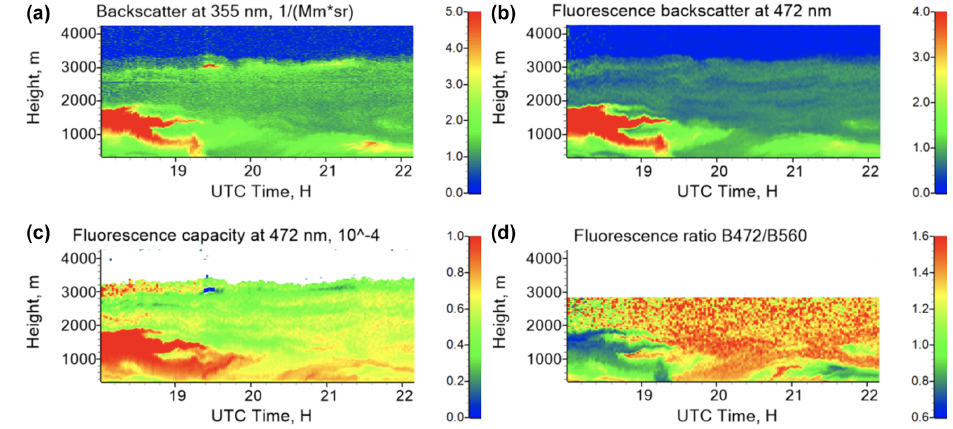
Figure 7. Observations on 17 August 2022. (a, c) Aerosol-backscattering coefficient β 355 and fluorescence capacity G 472 . (b, d) Fluorescence-backscattering coefficient β F472 (in 10 − 4 Mm − 1 sr − 1 ) and the ratio of fluorescence-spectral-backscattering coefficients B 472 /B 560 .